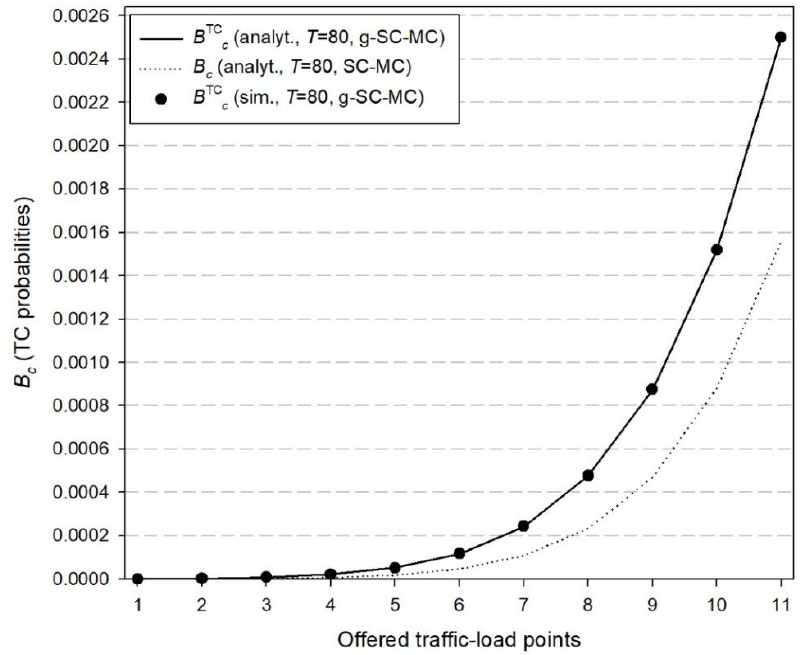
B and B ) for the first cluster and both models. c c